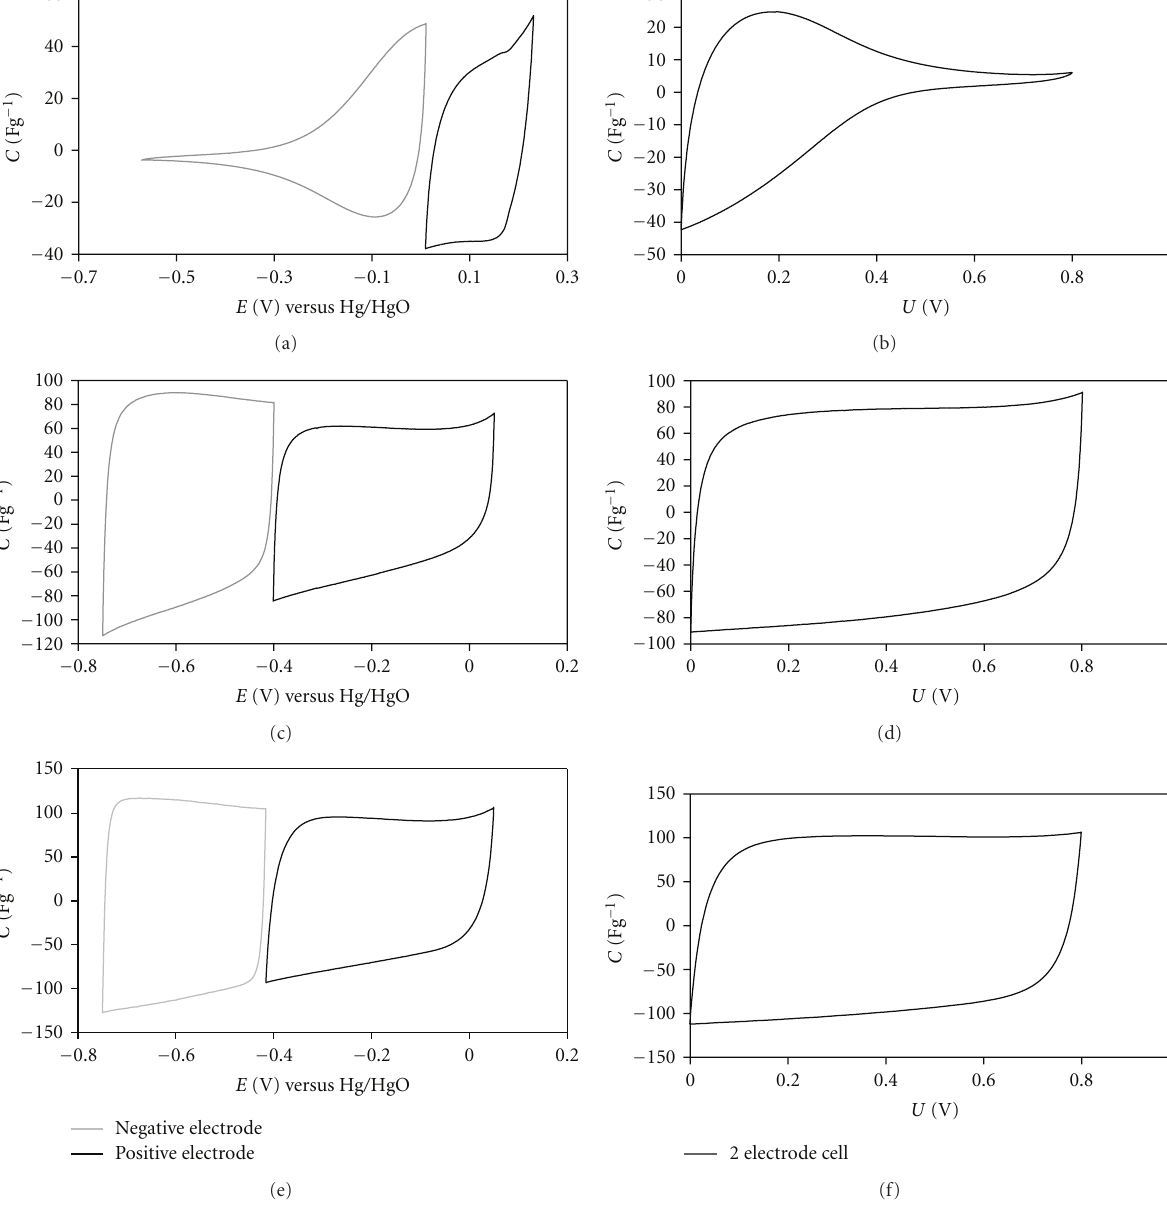
Figure 7: Voltammetry characteristics of NiO (a, b); AC (c, d); composite W3 (e, f). The CV (b, d, f) are made in a two-electrode Swagelok system at a scan rate 10mV/s, while curves (a, c, e) are made in a three-electrode Swagelok system at a scan rate of